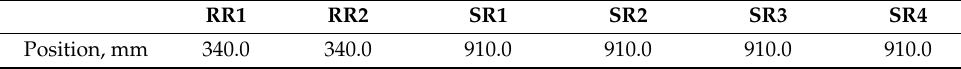
Table 2. Control rod position during sodium void reactivity measurement.